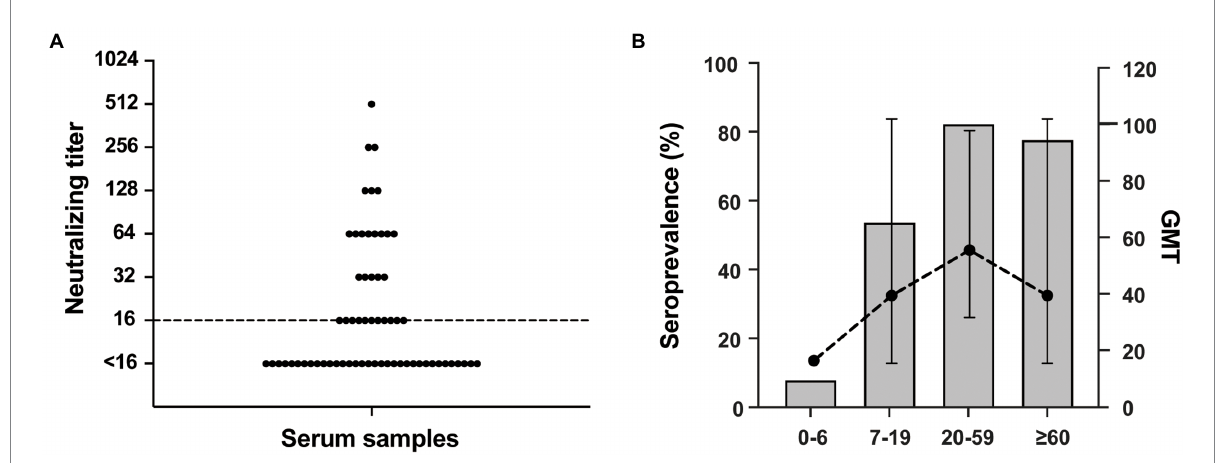
FIGURE 7 Detection of serum neutralizing antibodies against RV-C15 using Nt-ELISPOT. (A) A total of 64 serum samples were collected from a healthy population aged between 6 months and 74 years in Siming District of Xiamen City. The NAb titers against RV-C15 were detected by Nt-ELISPOT. Dotted line indicates the threshold for a positive neutralization titer ( ≥ 16). (B) Among the samples, the seroprevalence of different age groups is shown by histogram. The geometric mean titer (GMT) was calculated as the point plot noted. The bars indicate 95% confidence